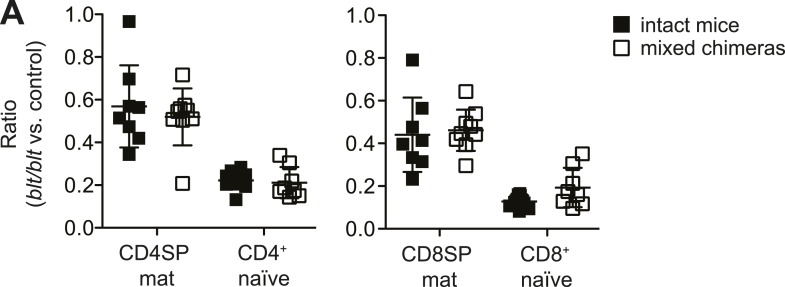
Similar relative decrease in blt/blt T cells in mixed chimeras vs
intact mice, indicating the lack of a competitive or rescue effect by WT
cells.(A) Ratio of blt/blt to WT
mature SP thymocytes and naïve T cells normalized to the ratio in DP
thymocytes from mixed chimeras (open symbols), compared to the ratio of
the same subsets between matched pairs of intact mice (filled symbols),
based on data reported in Figure
1. (mean ± s.d., n = 9).